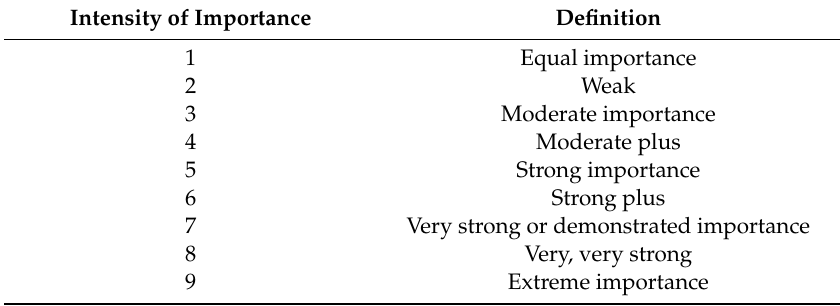
Table 1. Supplementary Materials).